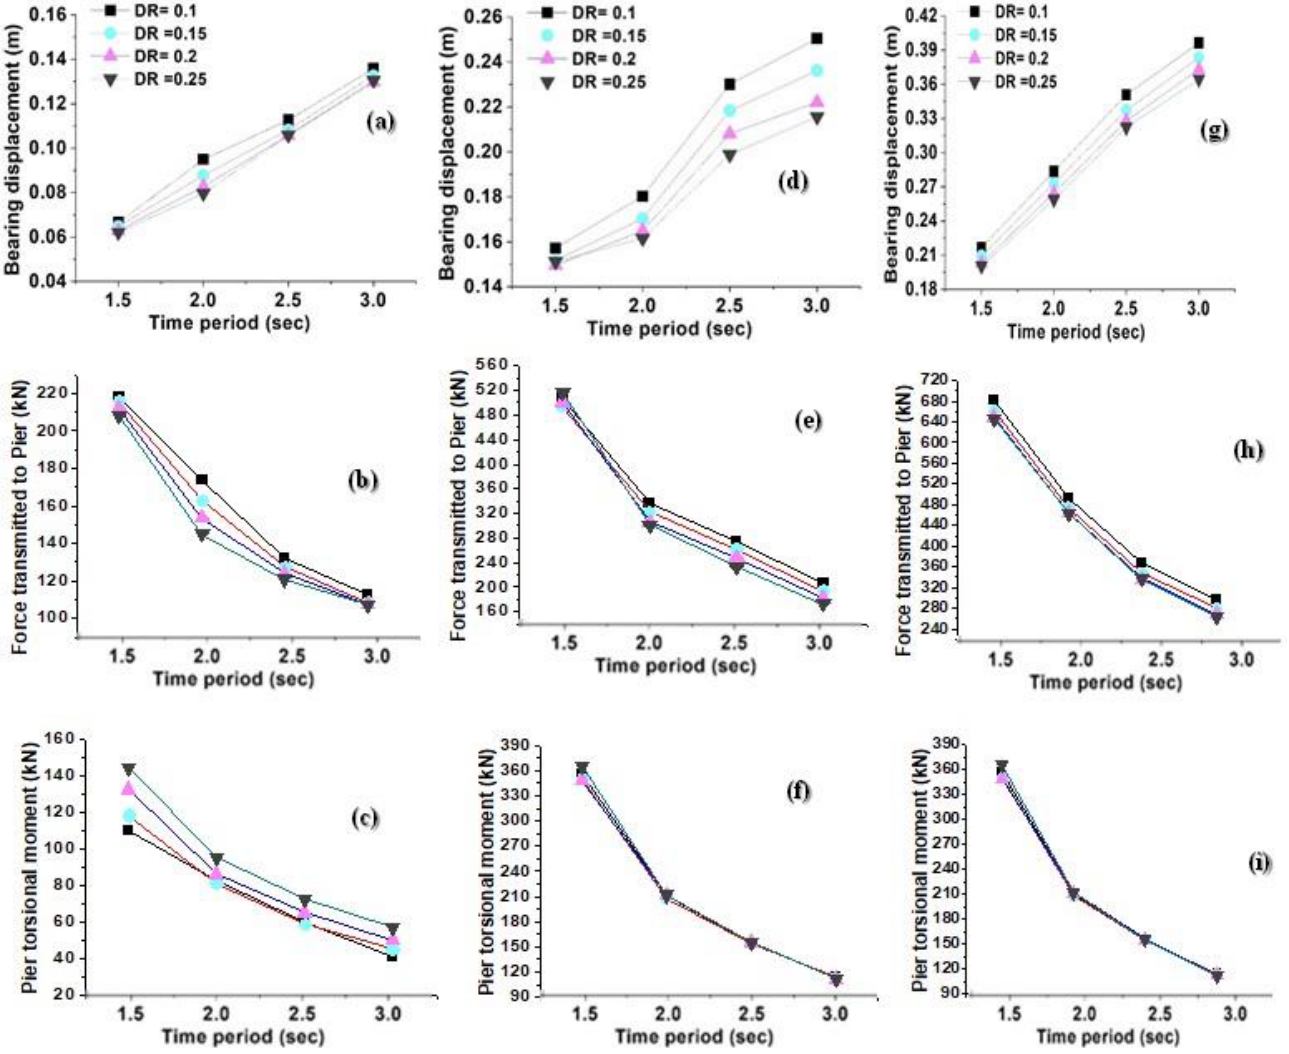
Figure 12. Response sensitivity of the isolated bridge with respect to the time period of LRB for bi-directional (i) Imperial Valley ( a – c ), (ii) Kobe ( d – f ), and (iii) Turkey ( g – i ) ground motions.